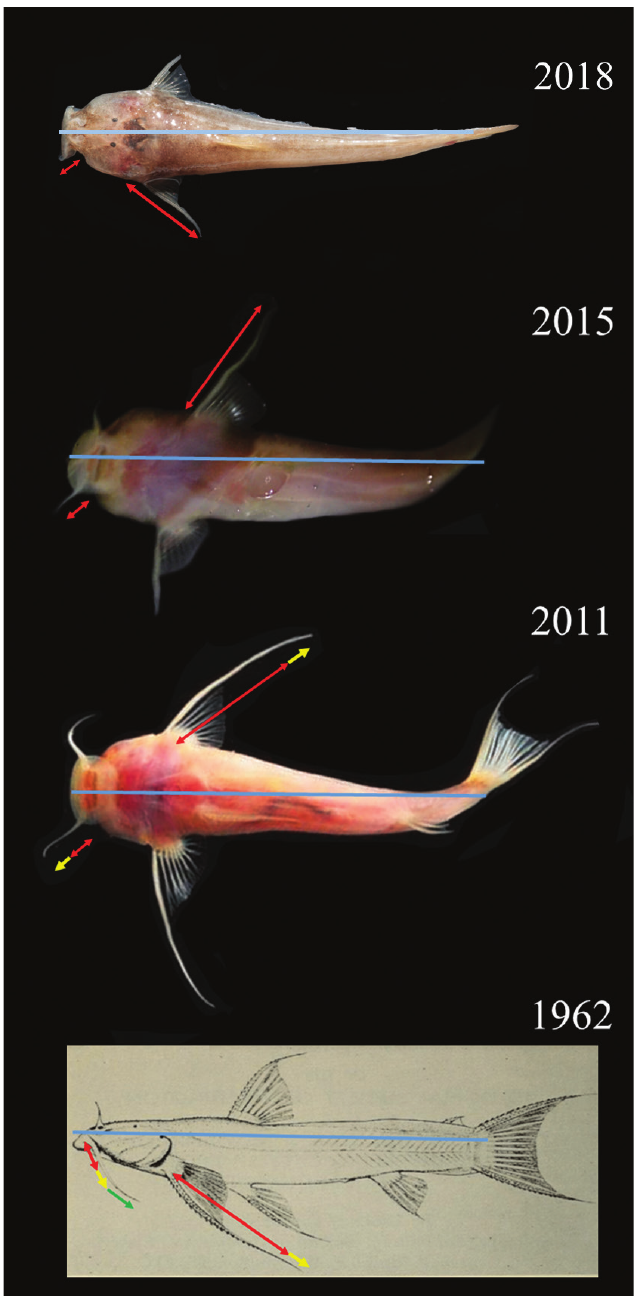
Figure 5. Specimens collected in 1962 ( A modified from Collette 1962) and 2011 ( B Modified from Soares and Niemiller 2013) had proportionally longer pectoral fins and maxillary barbels than specimens observed in the field in 2015 ( C ). Images have been scaled to the same body size (blue arrow). Notice that length of ap- pendages in C–D (red arrows) are progressively smaller than in B and A (red plus yellow and green